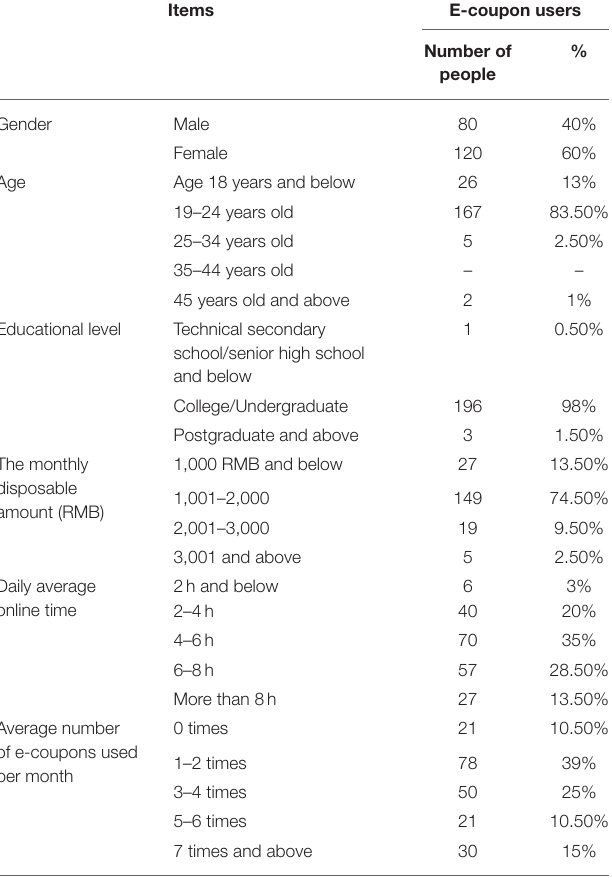
TABLE 1 | Description on the characteristics of research